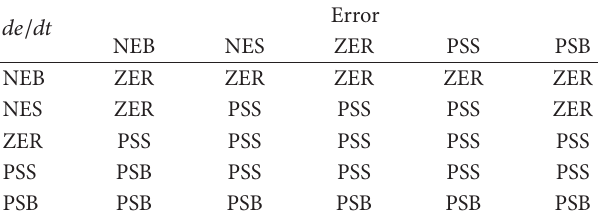
Table 2: If-then rule of fuzzy logic controller for 𝐾 𝑅